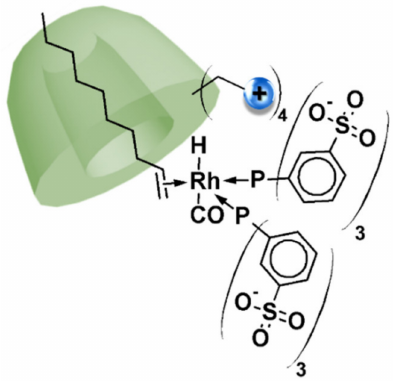
Figure 13. Rhodium complexes noncovalently bound to cationic α -CD bearing 2-hydroxy-3- trimethylammoniopropyl groups to perform biphasic hydroformylation of higher olefins.